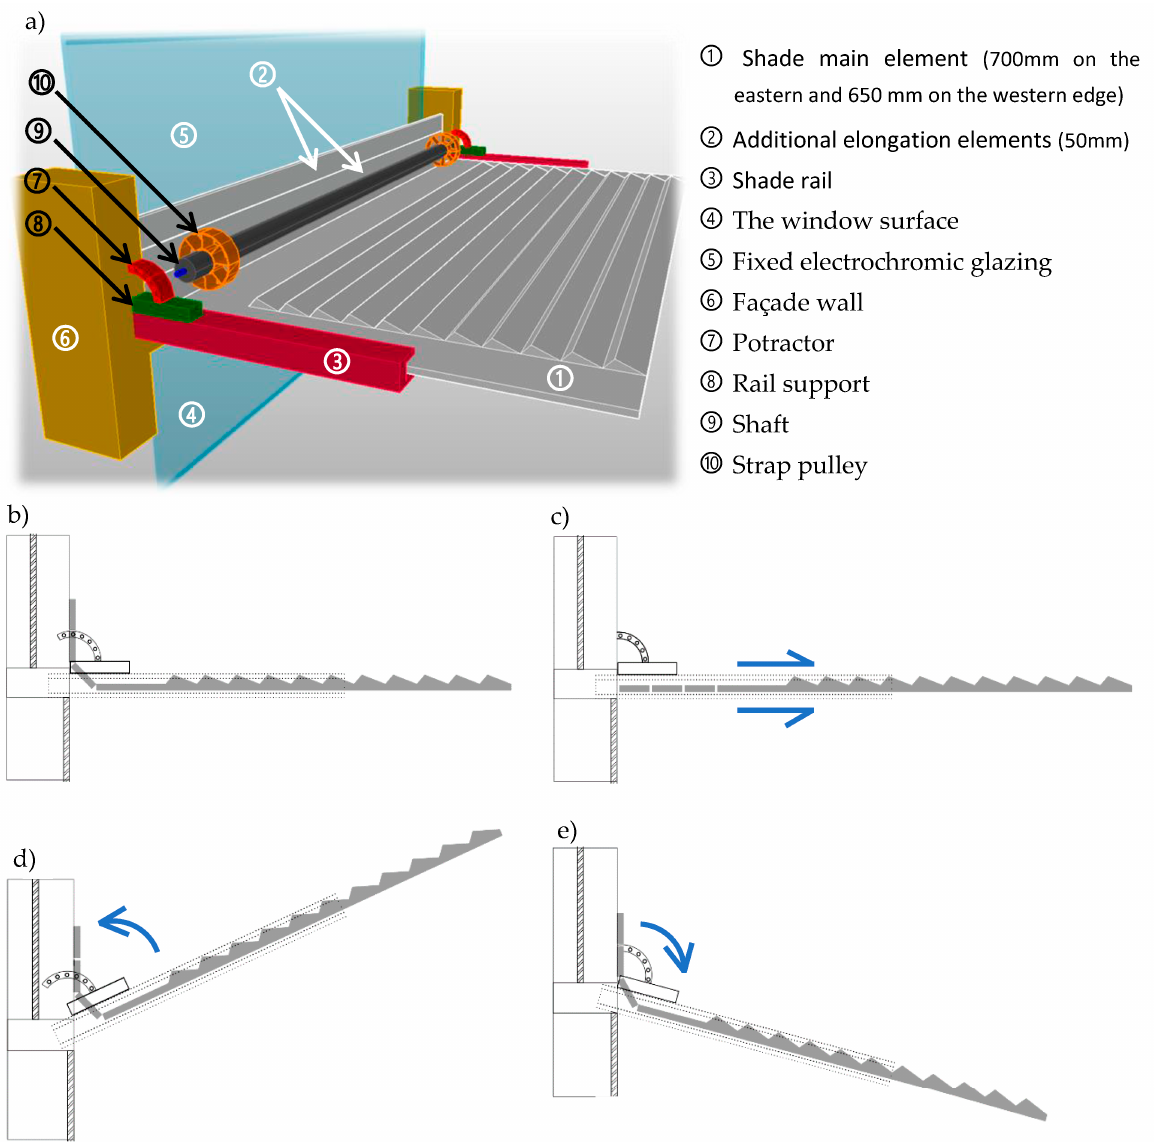
Figure 4. Kinetic shading mechanism ( a ) 3D view showing components in detail; ( b ) short horizontal mode; ( c ) extended horizontal mode; ( d ) Open mode; ( e ) inclined shade.